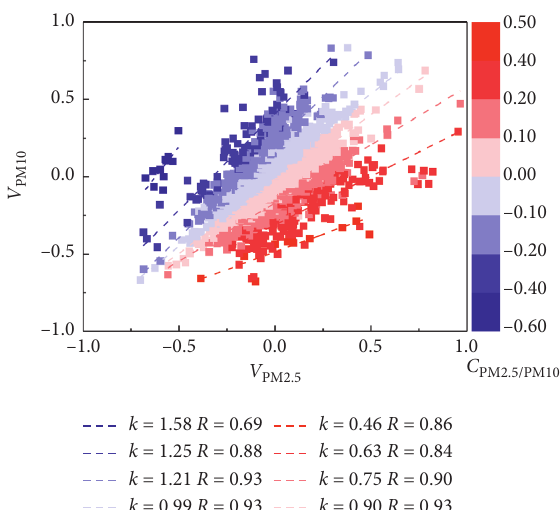
Figure 5: Relationships between V PM2.5 and V PM10 for different values of C PM2.5/PM10